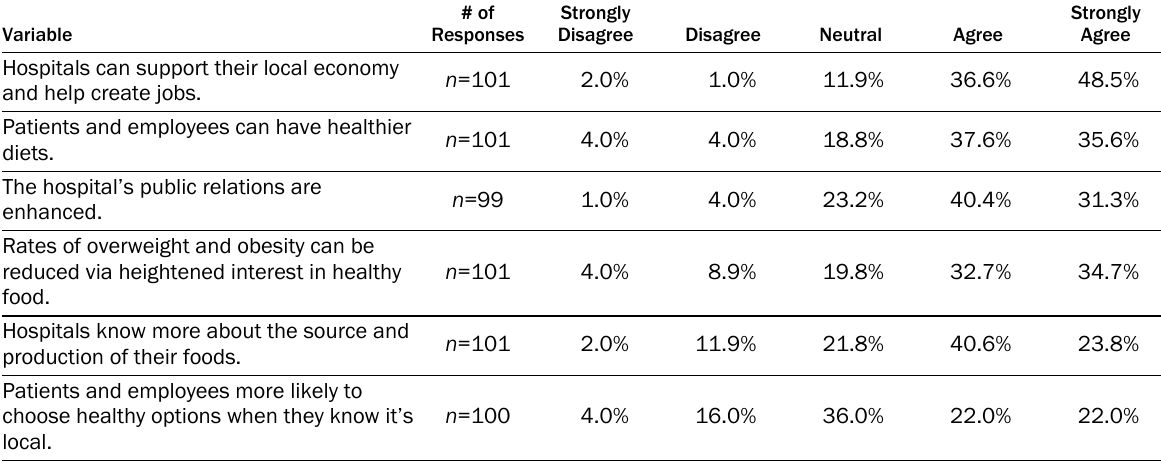
Table 6. Attitudes as Measured by Inquiring About Potential